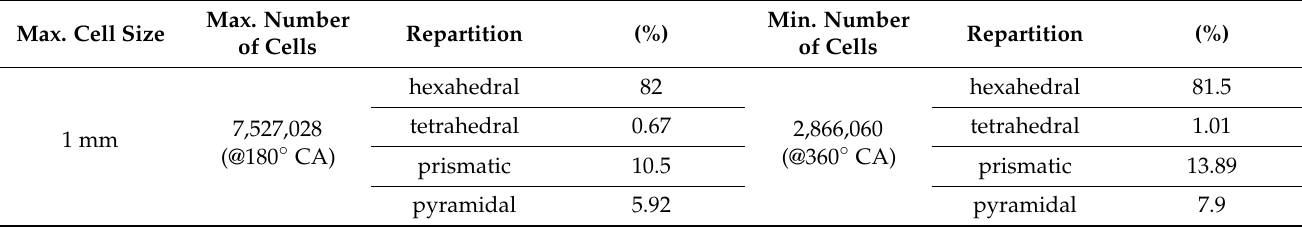
Table 1. Details of the geometry mesh.